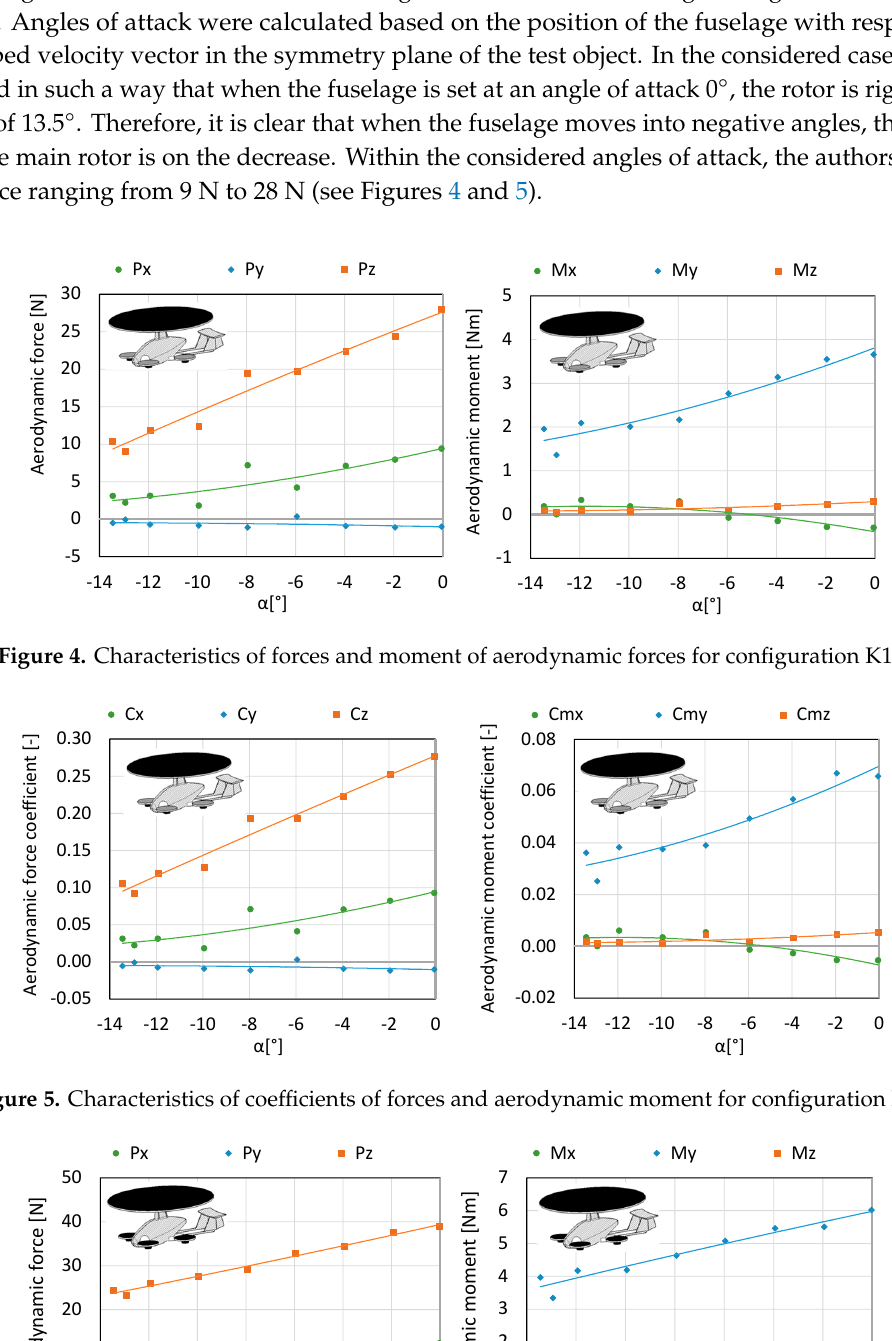
Figure 6. The characteristics of forces and moment for aerodynamic forces for configuration K2.